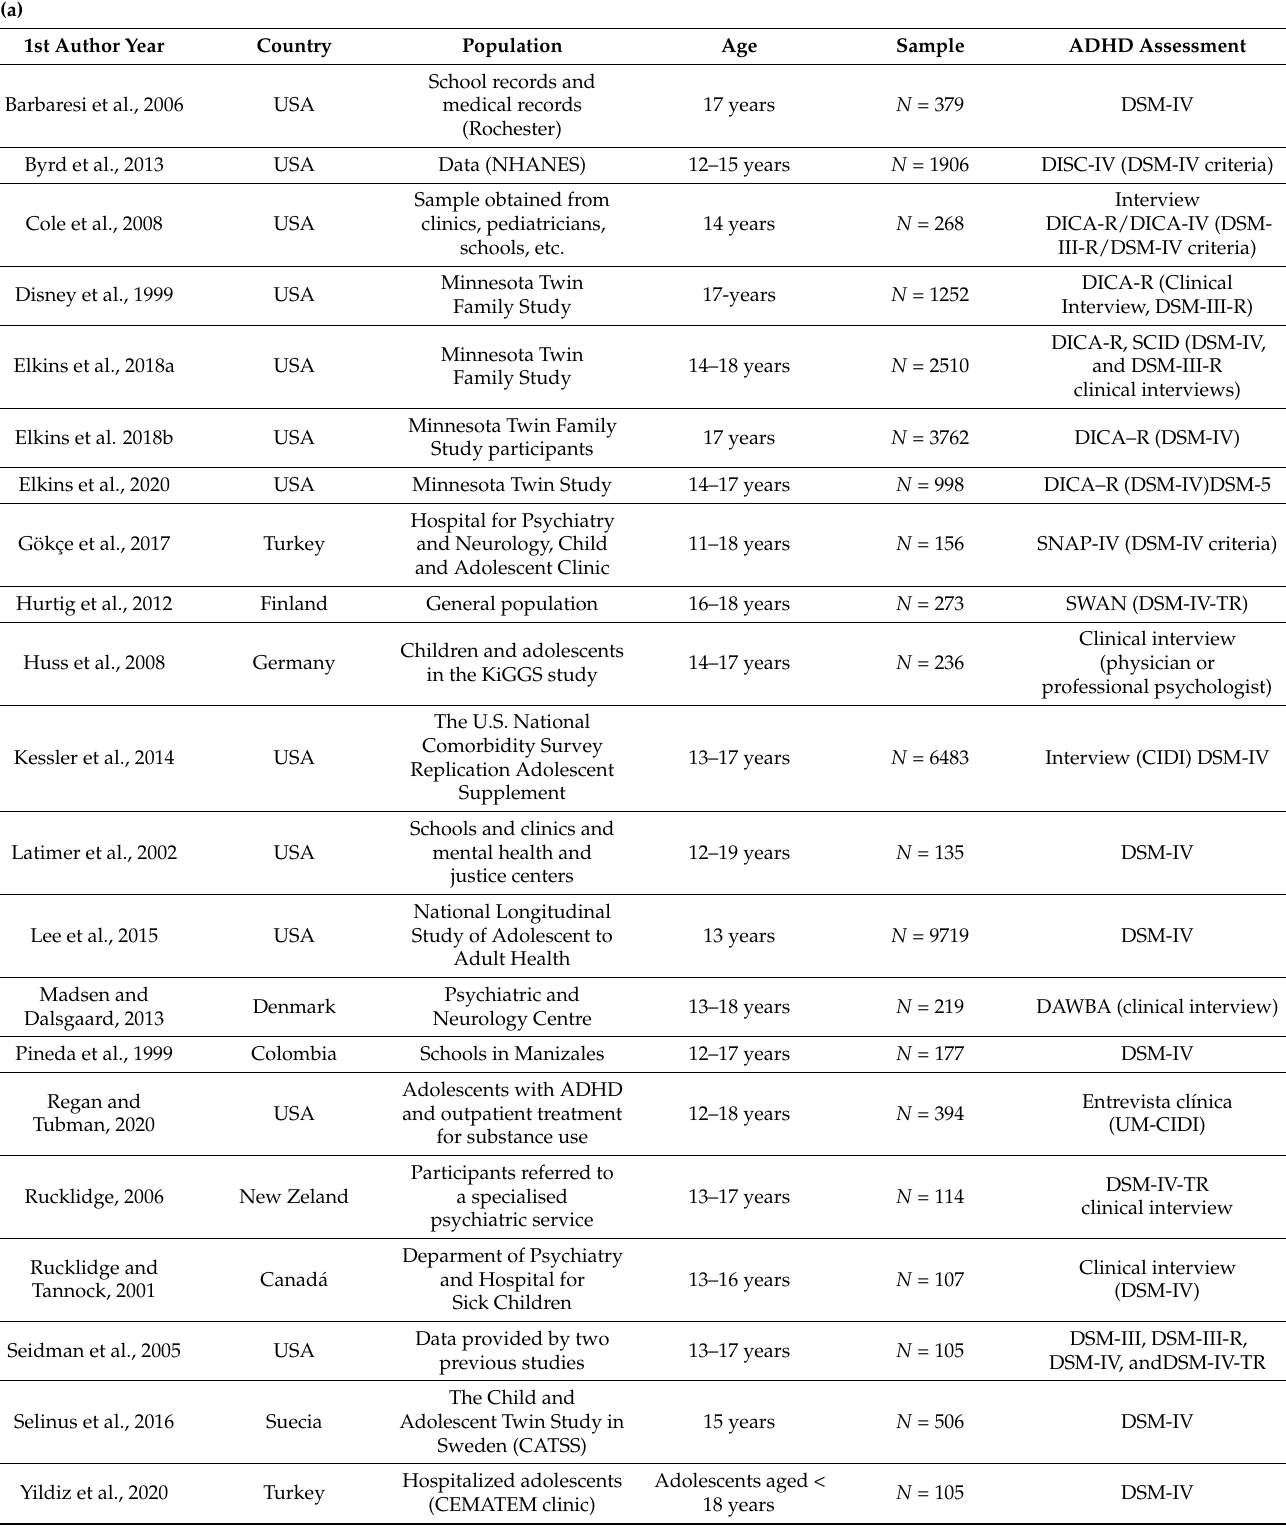
Table 1. ( a ) . Characteristics from sex differences’ studies on ADHD adolescents [40–60]. ( b ) Study type and quality evaluation from sex differences’ studies on ADHD adolescents